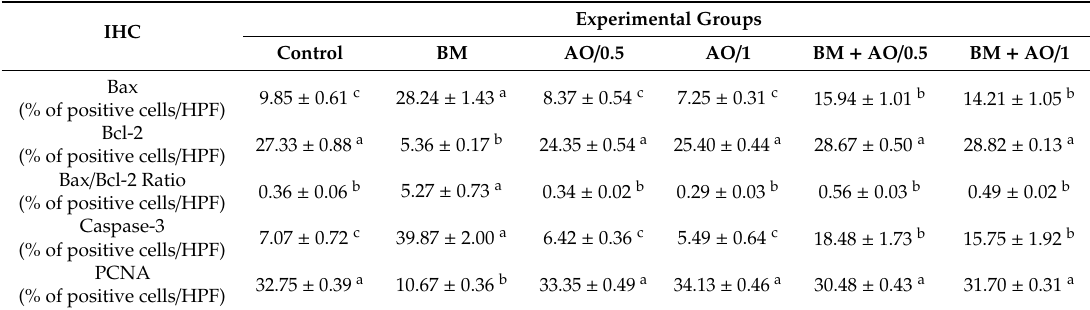
Table 5. Semiquantitative analysis of Bax, Bcl-2, Bax / Bcl-2 ratio, caspase-3, and PCNA immune-staining in the kidneys of di ff erent treated groups.